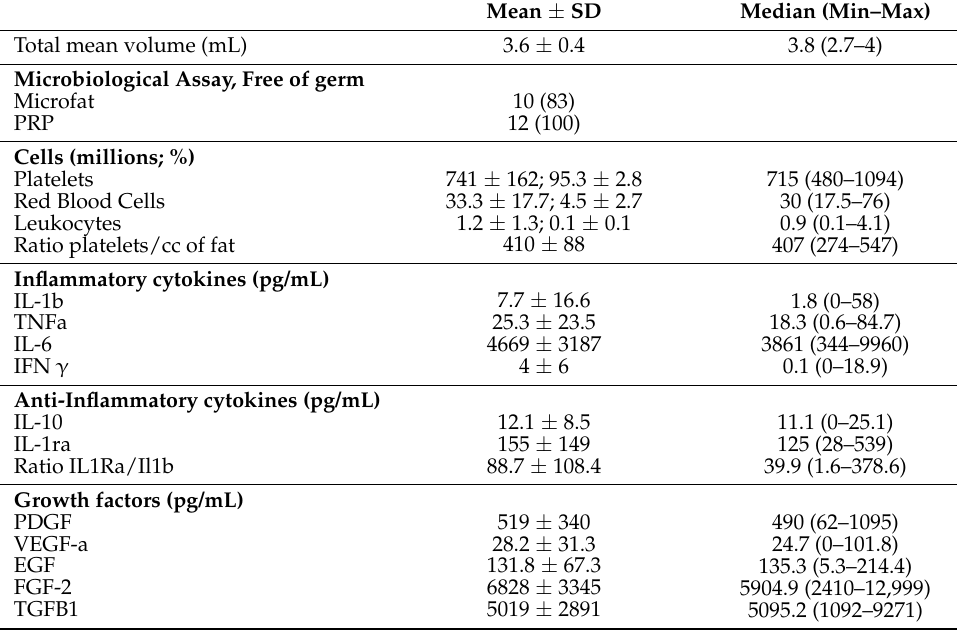
Table 3. Biological characteristics of experimental